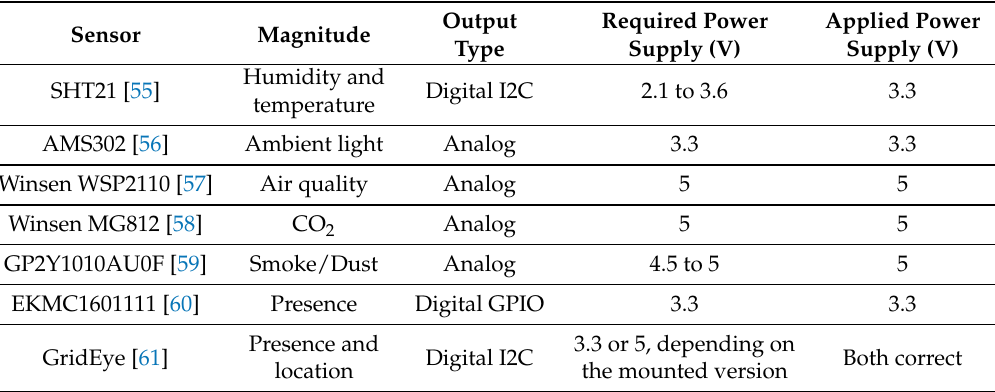
Table 1. Sensors and their